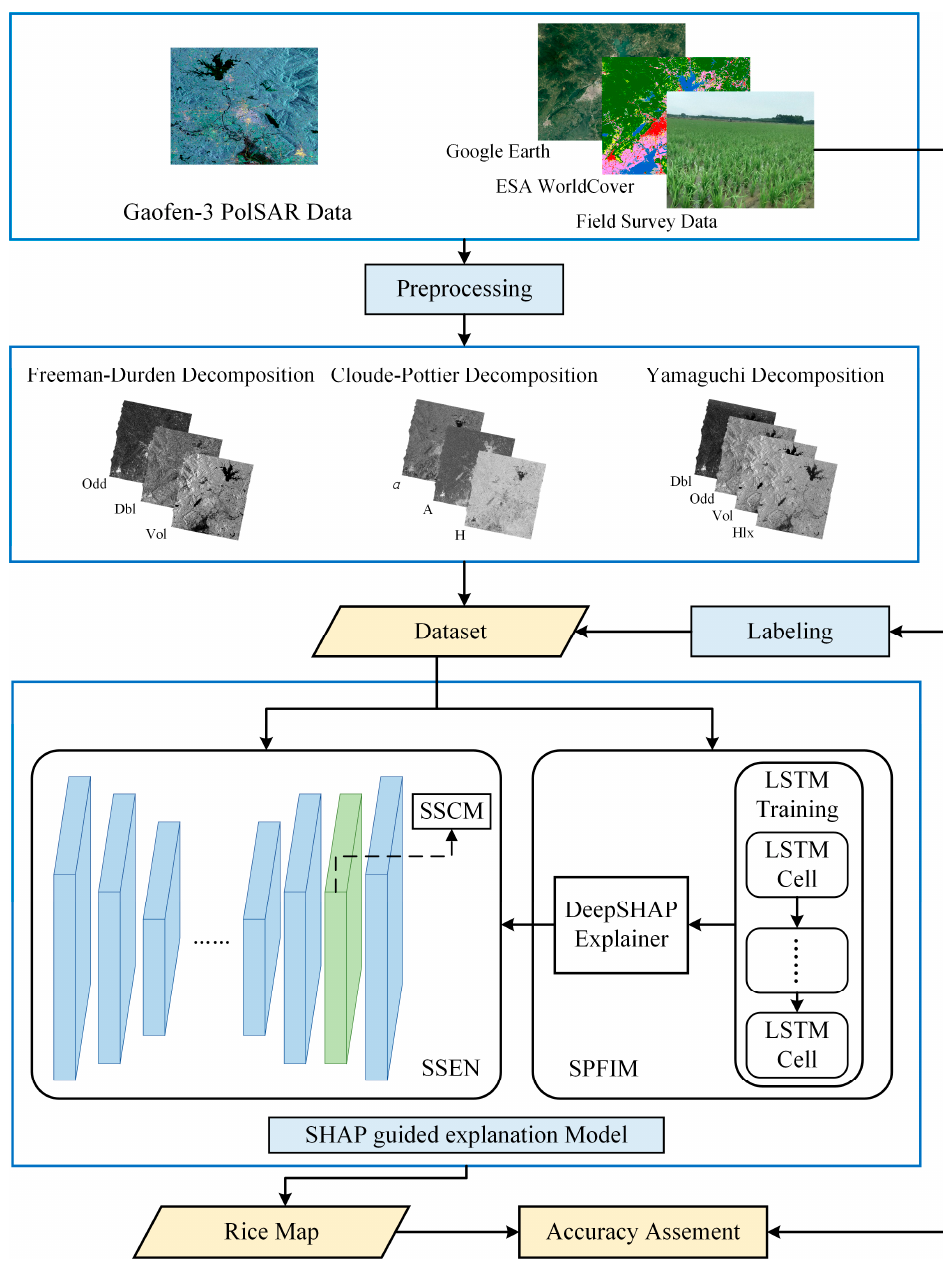
Figure 3. The flowchart of the proposed method.